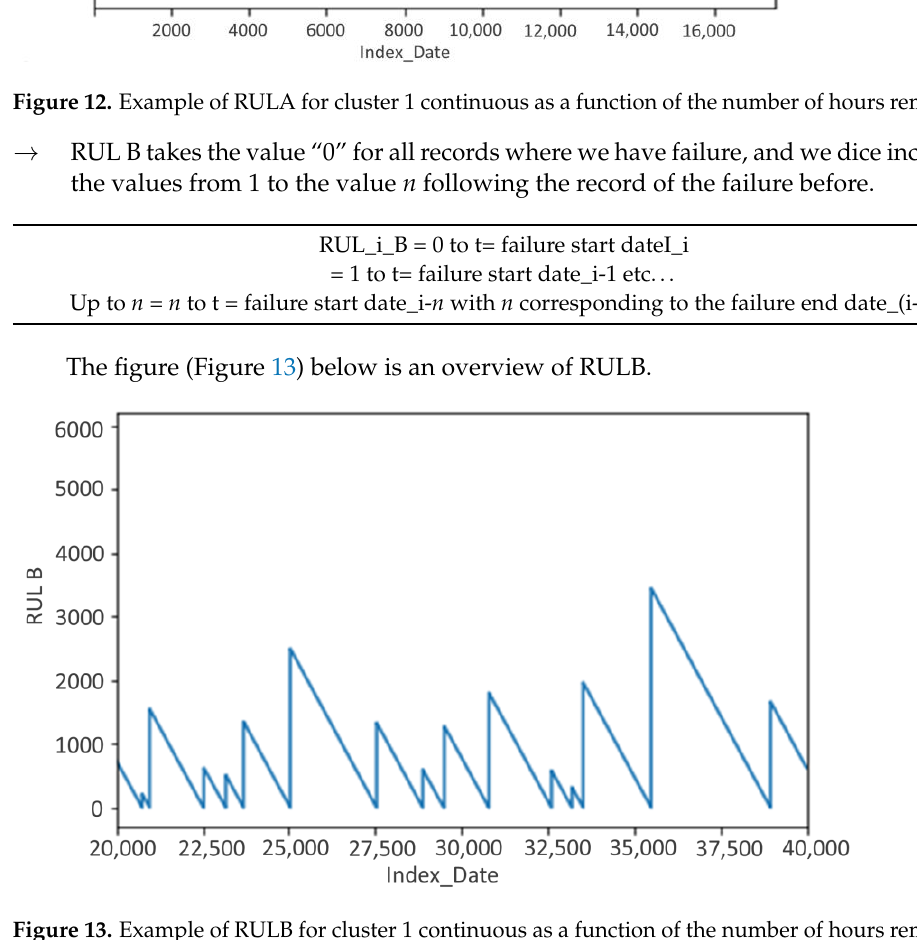
Figure 13. Example of RULB for cluster 1 continuous as a function of the number of hours remaining .